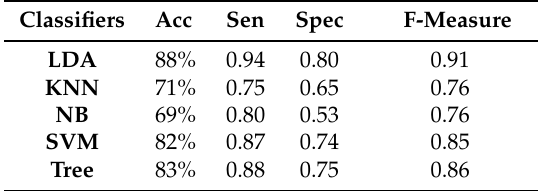
Table 6. Classification results using all features.